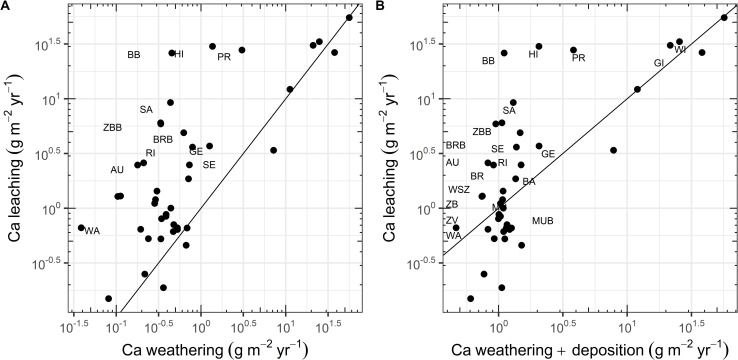
Relation between the leaching of Ca at a depth of 60–80 cm (average 2005–2018) and the weathering rate of base cations cumulated over the uppermost 60 cm.A: Relation between Ca leaching and weathering rate. B: Relation between Ca leaching and the sum of Ca weathering and Ca deposition. Site abbreviations can be found in Table 1. Only sites with Ca leaching exceeding the weathering input by a factor of 1.1 are labelled in the plot. The line represents the 1:1 line.